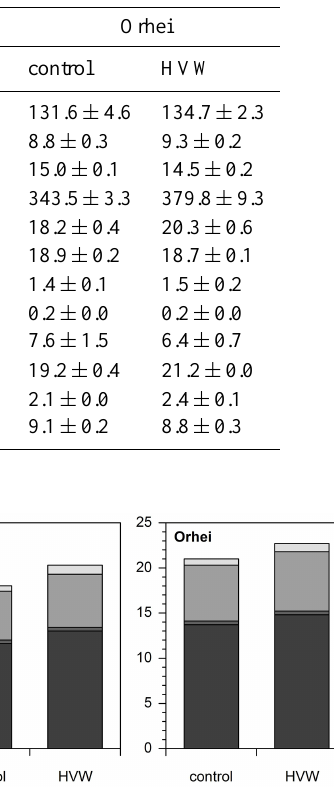
Figure 5. Organic carbon (OC) concentration of different soil fractions ( f POM is free particulate organic matter; o POM is aggregate-occluded particulate organic matter; MOM > 20µm is coarse mineral-associated organic matter; MOM < 20µm is fine mineral-associated organic matter) in topsoils (0 to 12cm) of con- trol and HVW